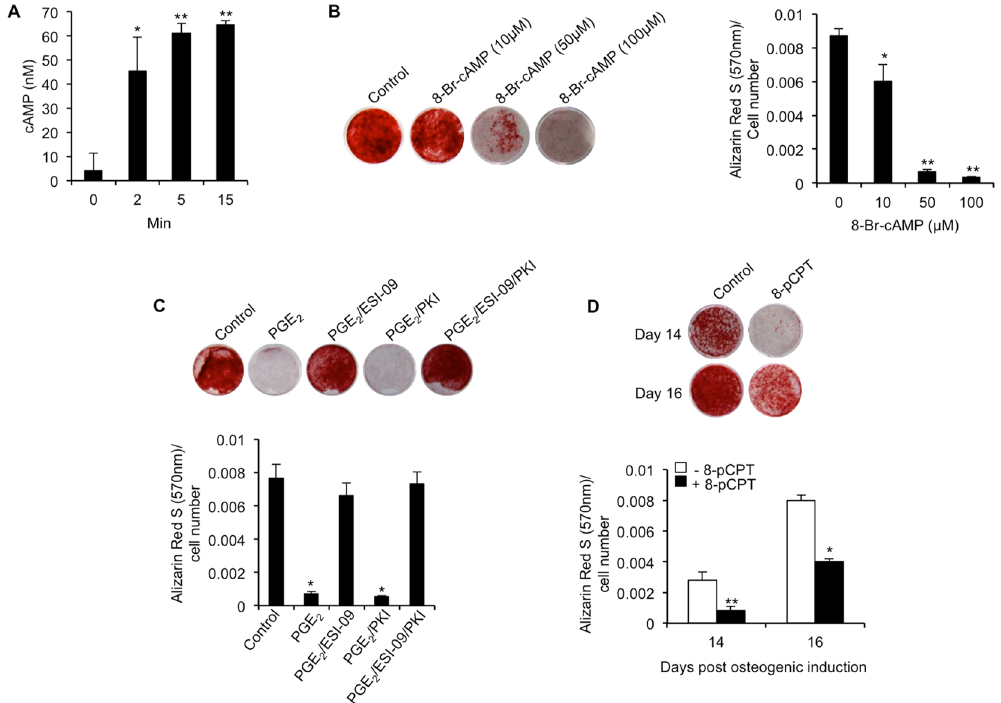
Figure 6. PGE 2 inhibits hBMSC-mediated matrix mineralization via Epac-dependent cAMP signaling. ( A ) Intracellular cAMP levels were measured in hBMSCs treated with PGE 2 (100 nM) for 2, 5 and 15 min. * p < 0.01, ** p < 0.001, as compared to untreated cells using ANOVA. ( B ) hBMSCs undergoing osteogenic differentiation were treated continuously with cAMP analog 8-Br-cAMP, and matrix mineralization quantified at day 14 by Alizarin Red S staining. * p < 0.01, ** p < 0.001 as compared to control using ANOVA. ( C ) hBMSCs were continuously cultured in the absence (control) or presence (PGE 2 ) of PGE 2 (10 nM) with or without Epac inhibitor ESI-09 (10 μ M) or PKA inhibitor PKI (10 μ M), and matrix mineralization quantified at day 14 by Alizarin Red S staining. * p < 0.001 as compared to control using ANOVA. ( D ) hBMSCs undergoing osteogenic differentiation were treated continuously with cAMP analog 8-pCPT-2-O-Me-cAMP (8-pCPT) (50 μ M), and matrix mineralization quantified at day 14 and 16 by Alizarin Red S staining. * p < 0.01, ** p < 0.001 as compared to control ( − 8-pCPT) using Student’s t-test. The data represent triplicate determinations and were replicated at least two times. All values are presented as mean ±